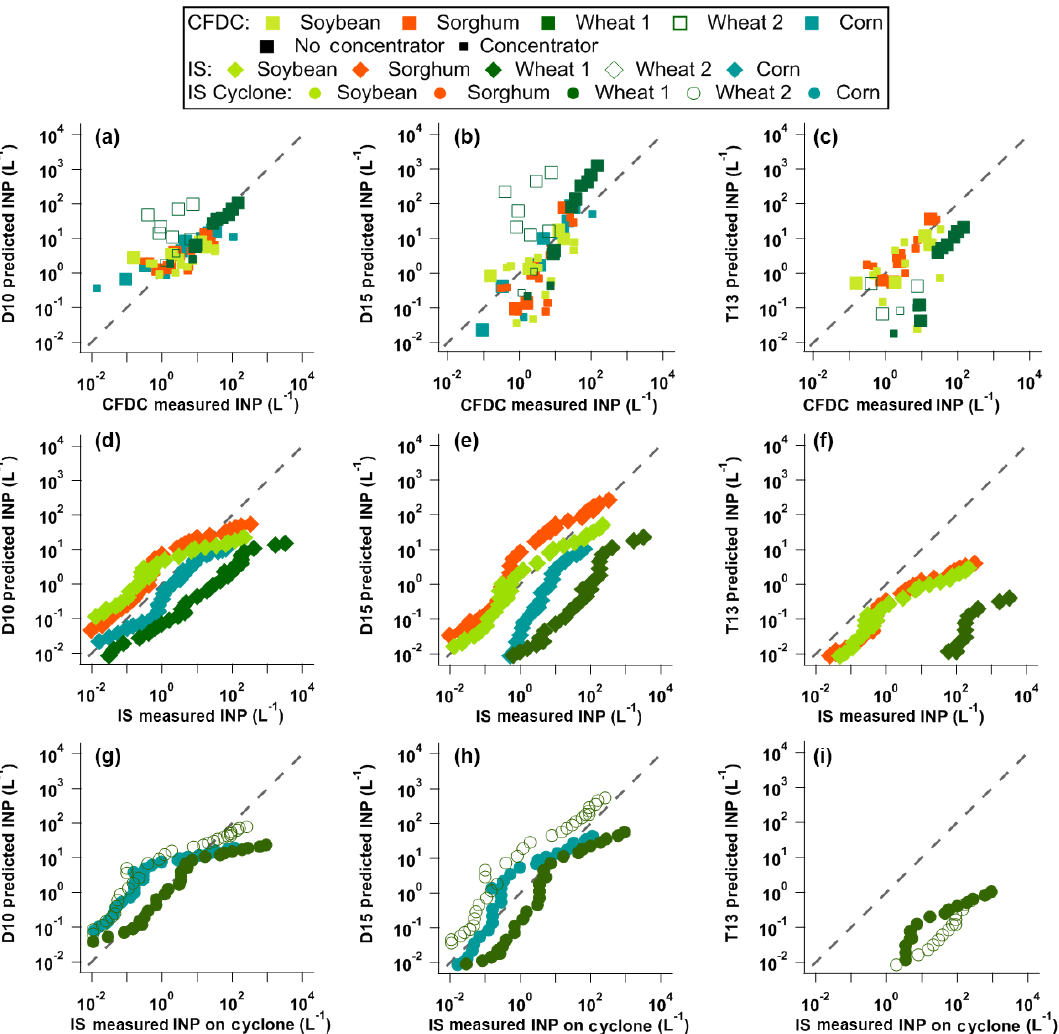
Figure 8. Measured CFDC (a–c) , IS (d–f) , and IS behind a 2.5µm cyclone (g–i) . INP number concentrations plotted against predicted INP number concentrations using the D10 (a, d, g) , D15 (b, e, h) , and T13 (c, f, i) parameterizations. The markers are colored by the different harvests; the size of the CFDC square markers indicates if the concentrator was used (smaller squares) or not (larger squares). The grey dashed line represents a 1 : 1 line for measured versus predicted